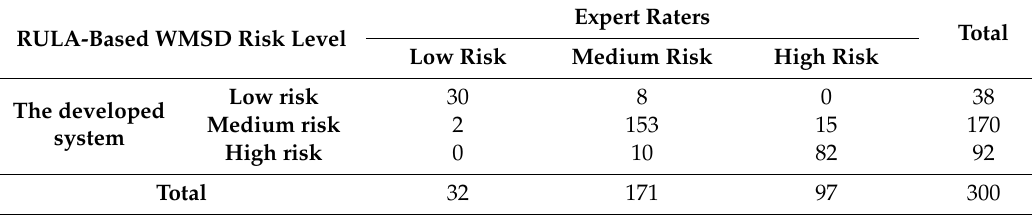
Table 2. RULA-based WMSD risk level classification agreement between the developed system and the expert